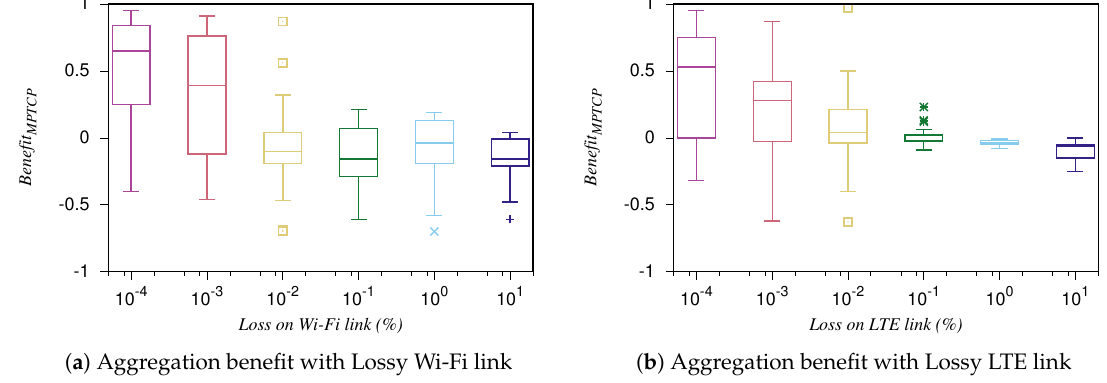
Figure 3. The aggregation benefit of MPTCP in different loss conditions.